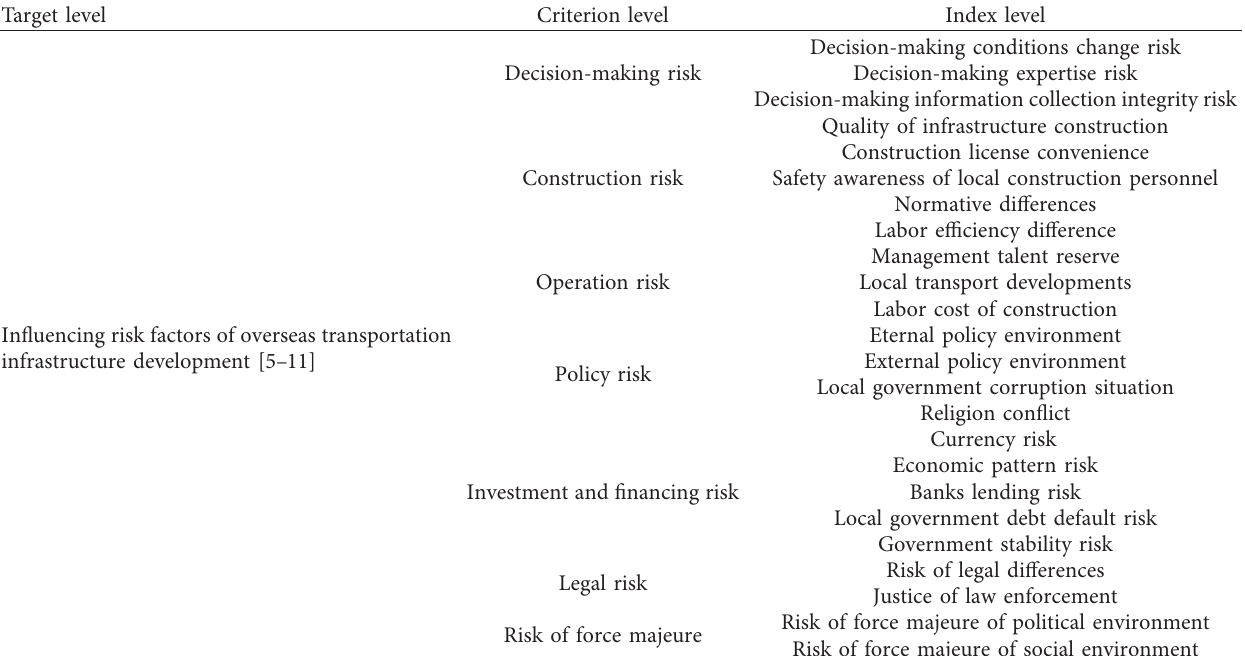
Table 1: Risk factors of overseas transportation infrastructure